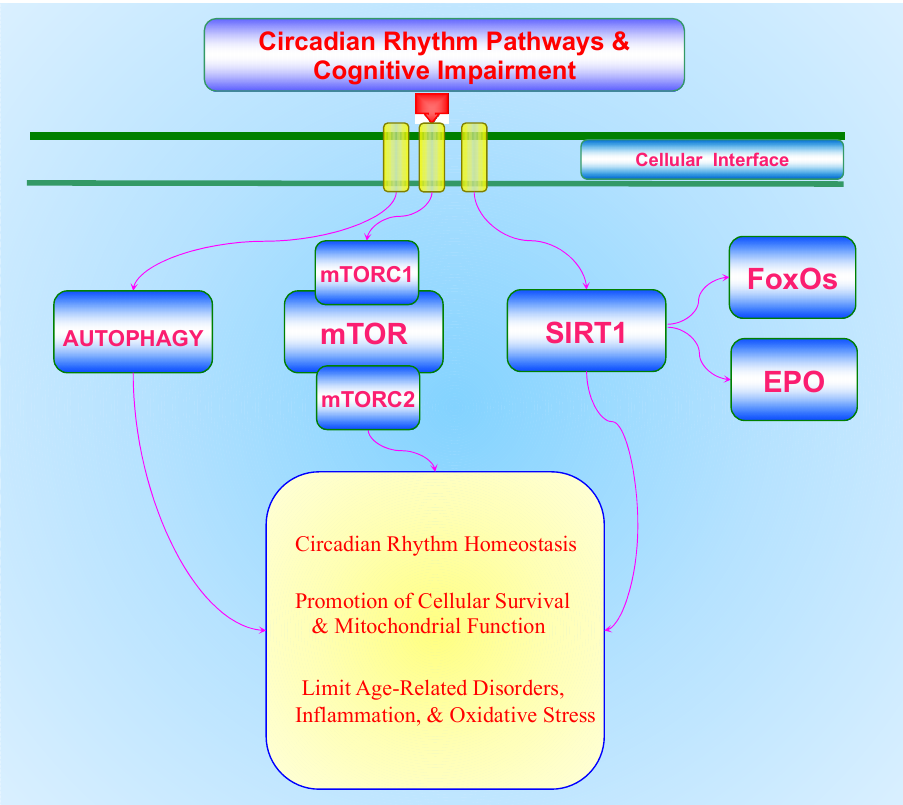
Figure 1. Circadian Rhythm Pathways during Cognitive Impairment. The circadian clock gene pathways provide exciting avenues for the comprehension of the multiple pathways that ultimately can lead to cognitive loss and dementia. These pathways that involve autophagy, the mechanistic target of rapamycin (mTOR), mTOR Complex 1 (mTORC1), mTOR Complex 2 (mTORC2), the silent mating type information regulation 2 homolog 1 (Saccharomyces cerevisiae ) (SIRT1), mammalian forkhead transcription factors (FoxOs), and erythropoietin (EPO) are complex in nature and require fine biological modulation. Ultimately, circadian rhythm clock genes are critical for the foundation of cog- nitive health and require maintenance of circadian rhythm homeostasis, prevention of mitochondrial dysfunction that can lead to cellular injury, and preventing the progression of age-related disorders, inflammation, and oxidative